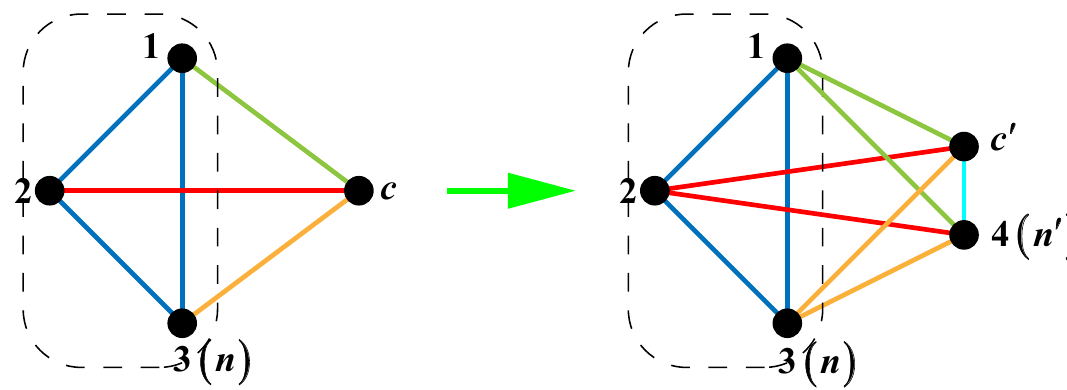
Figure 7 . When A c is further decomposed into two new elementary regions A c 0 and A n 0 , the n number of original flow fluxes F ci is now replaced by 2 n number of flow fluxes { F c 0 i , F n 0 i } , and a new flow flux F c 0 n 0 is added. We use different colors to show the changing of the flows in this